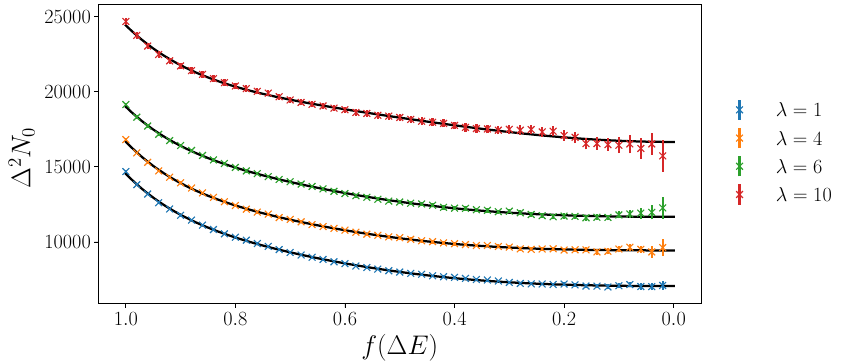
Figure 7: Fluctuations of atom number obtained after post-selection. The atom num- ber variance ∆ 2 N for different aspect ratios λ is shown as a function of the fraction 0 f after post-selection. Thus the figure represents the transition from a canonical to a microcanonical result from left to right with solid black lines showing the polynomial fits. The initial sets represent N = 10 4 atoms at the temperature T canonical variance is